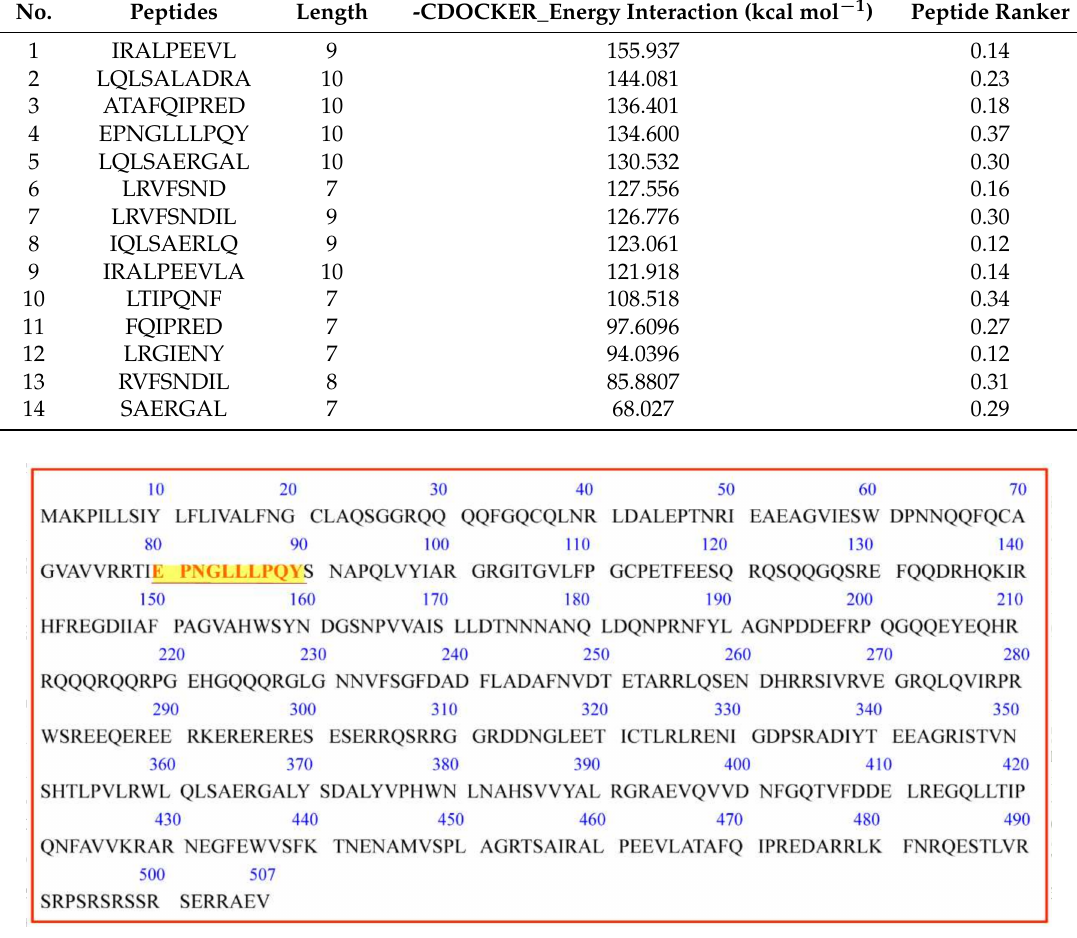
Figure 2. Location of EPNGLLLPQY in walnut seed storage protein